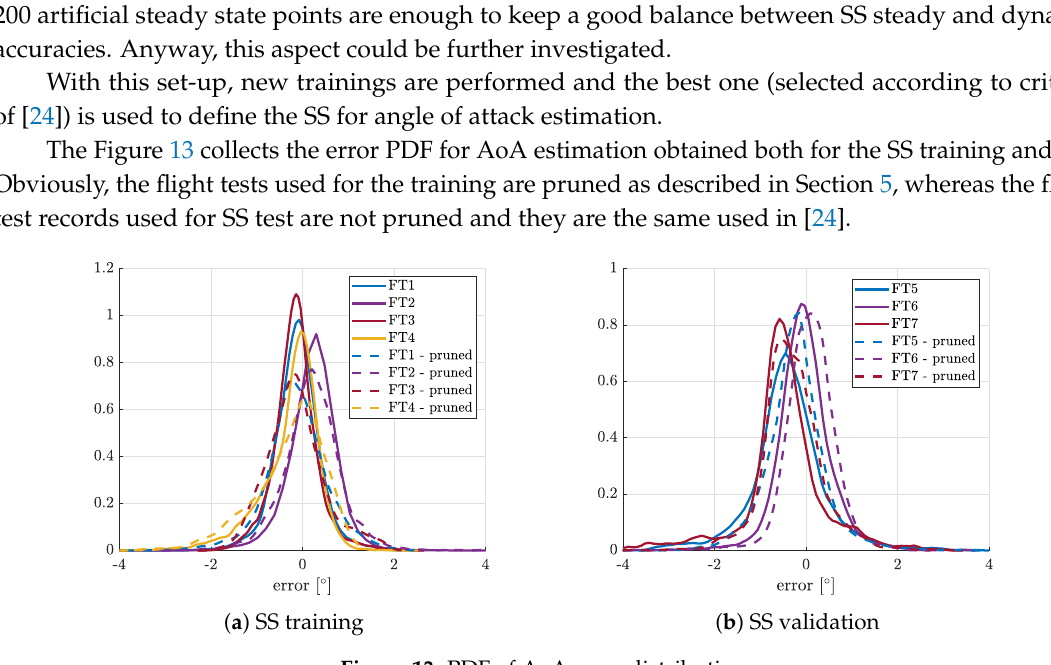
Figure 13. PDF of AoA error